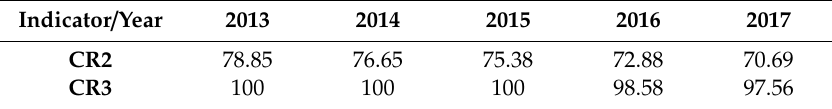
Table 2. Values of CR2 a CR3 in the period